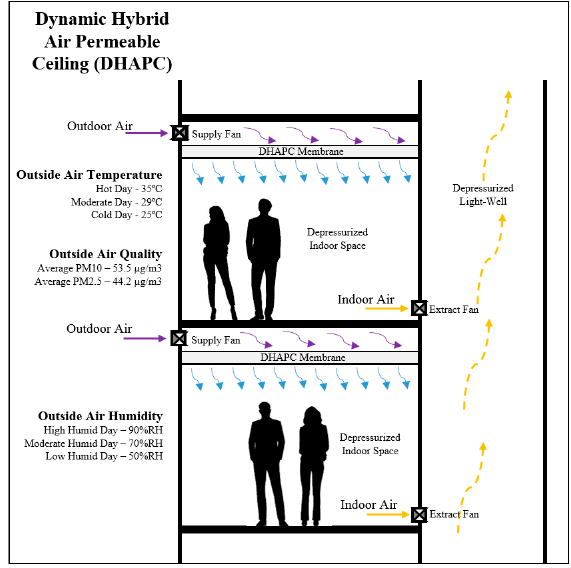
Figure 12. Dynamic hybrid air-permeable ceiling (DHAPC) schematic design in a high-rise building (not to scale).